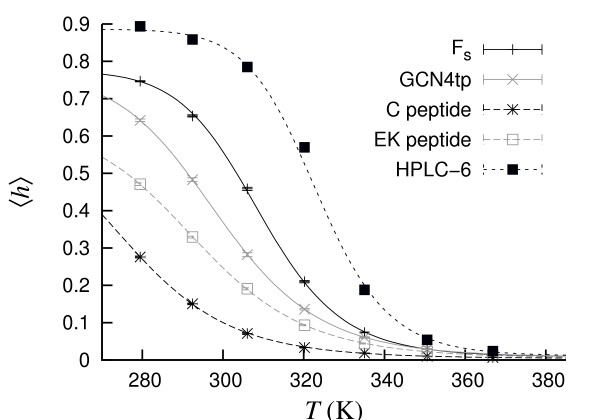
The C, EK, Fs, GCN4tp and HPLC-6 peptides. Helix content h against temperature. The lines are two-state fits (Tm = 276.3 ± 2.4 K and ΔE = 11.7 ± 0.4 kcal/mol for C; Tm = 293.9 ± 0.4 K and ΔE = 12.6 ± 0.2 kcal/mol for EK; Tm = 309.2 ± 0.3 K and ΔE = 18.7 ± 0.4 kcal/mol for Fs; Tm = 298.9 ± 0.1 K and ΔE = 14.1 ± 0.1 kcal/mol for GCN4tp; Tm = 323.3 ± 1.2 K and ΔE = 23.6 ± 2.2 kcal/mol for HPLC-6).